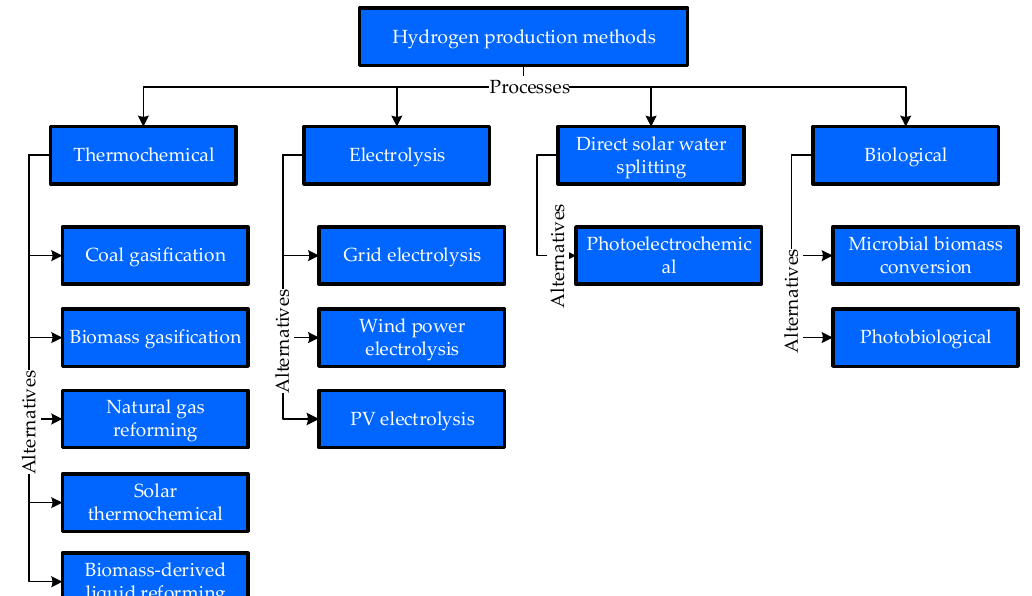
Figure 2. Hydrogen production alternatives.